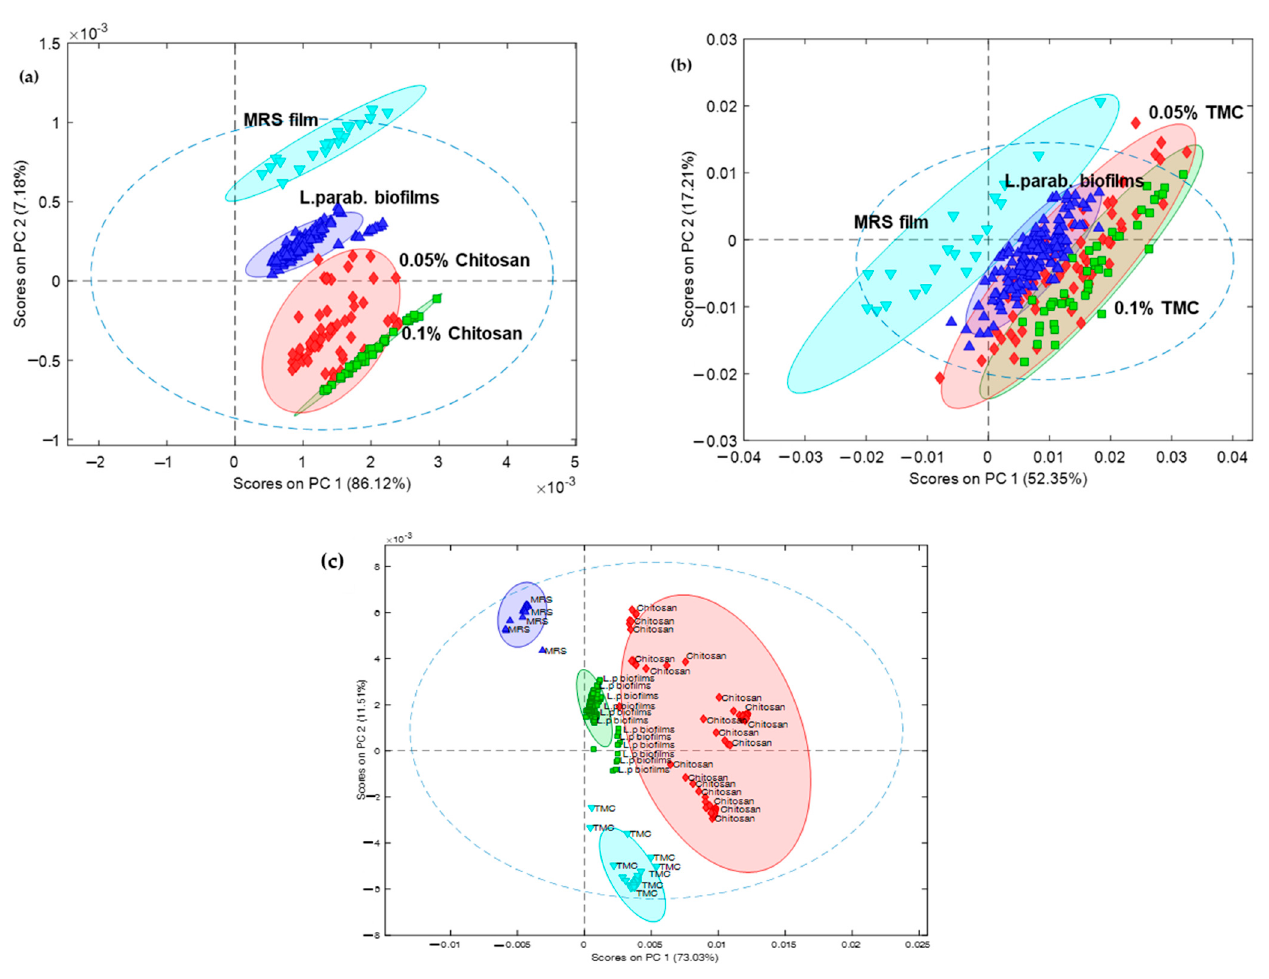
Figure 7. Multivariate data strategy for identification of the natural antibacterial performance of chitosan and its methylated derivative against Lentilactobacillus parabuchneri biofilms. ( a ) score plot of two PCAs of control biofilms treated with 0.05% and 0.1% chitosan, ( b ) PCA1-PCA2 plot of biofilm inhibition by 0.05% and 0.1% trimethyl chitosan (TMC), and ( c ) discriminant model based on principal component scores of real-time monitoring of reduced biofilms resulting from treatment with chitosan and TMC.